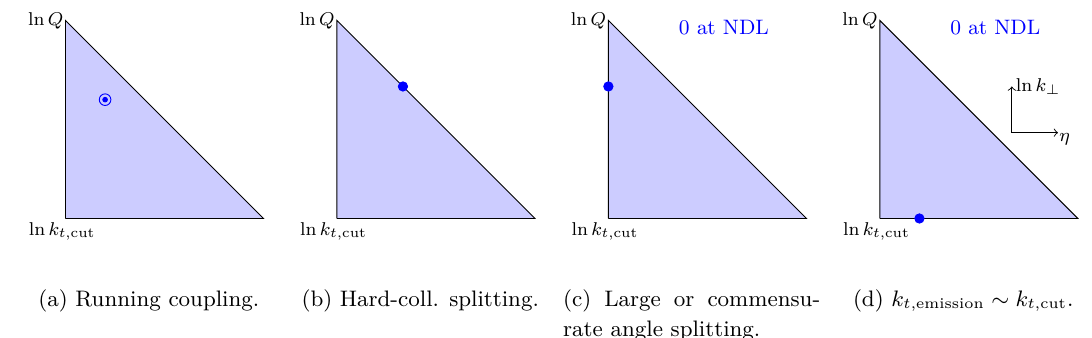
Figure 2. Lund representation of the configurations that potentially contribute to the multiplicity at NDL. The diagrams are drawn for the primary Lund plane but similar contributions exist for subsidiary planes as